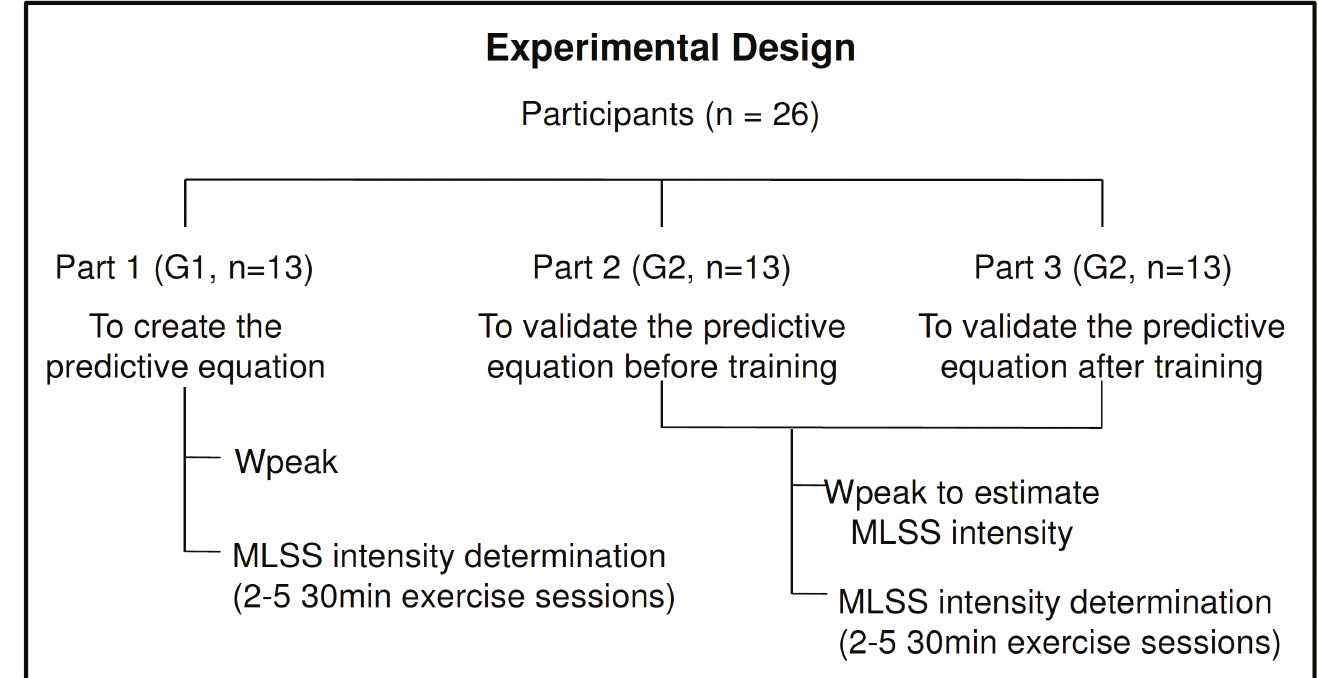
Figure 1. Overview of the experimental